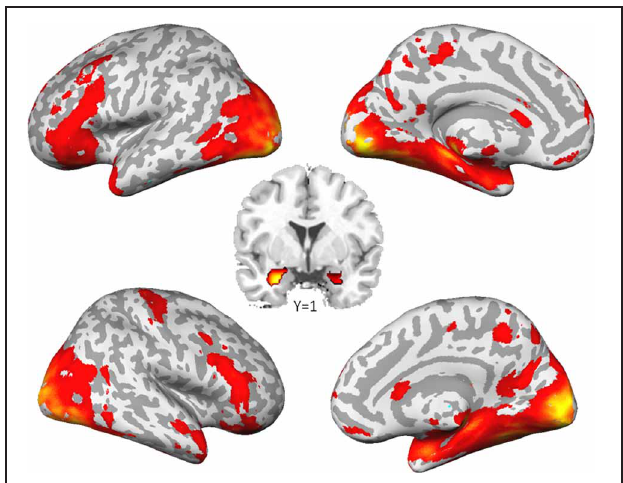
FIGURE 1 | Brain activation to social stimuli compared to non-social stimuli. ( p < 0 . 05, family wise error corrected for the whole